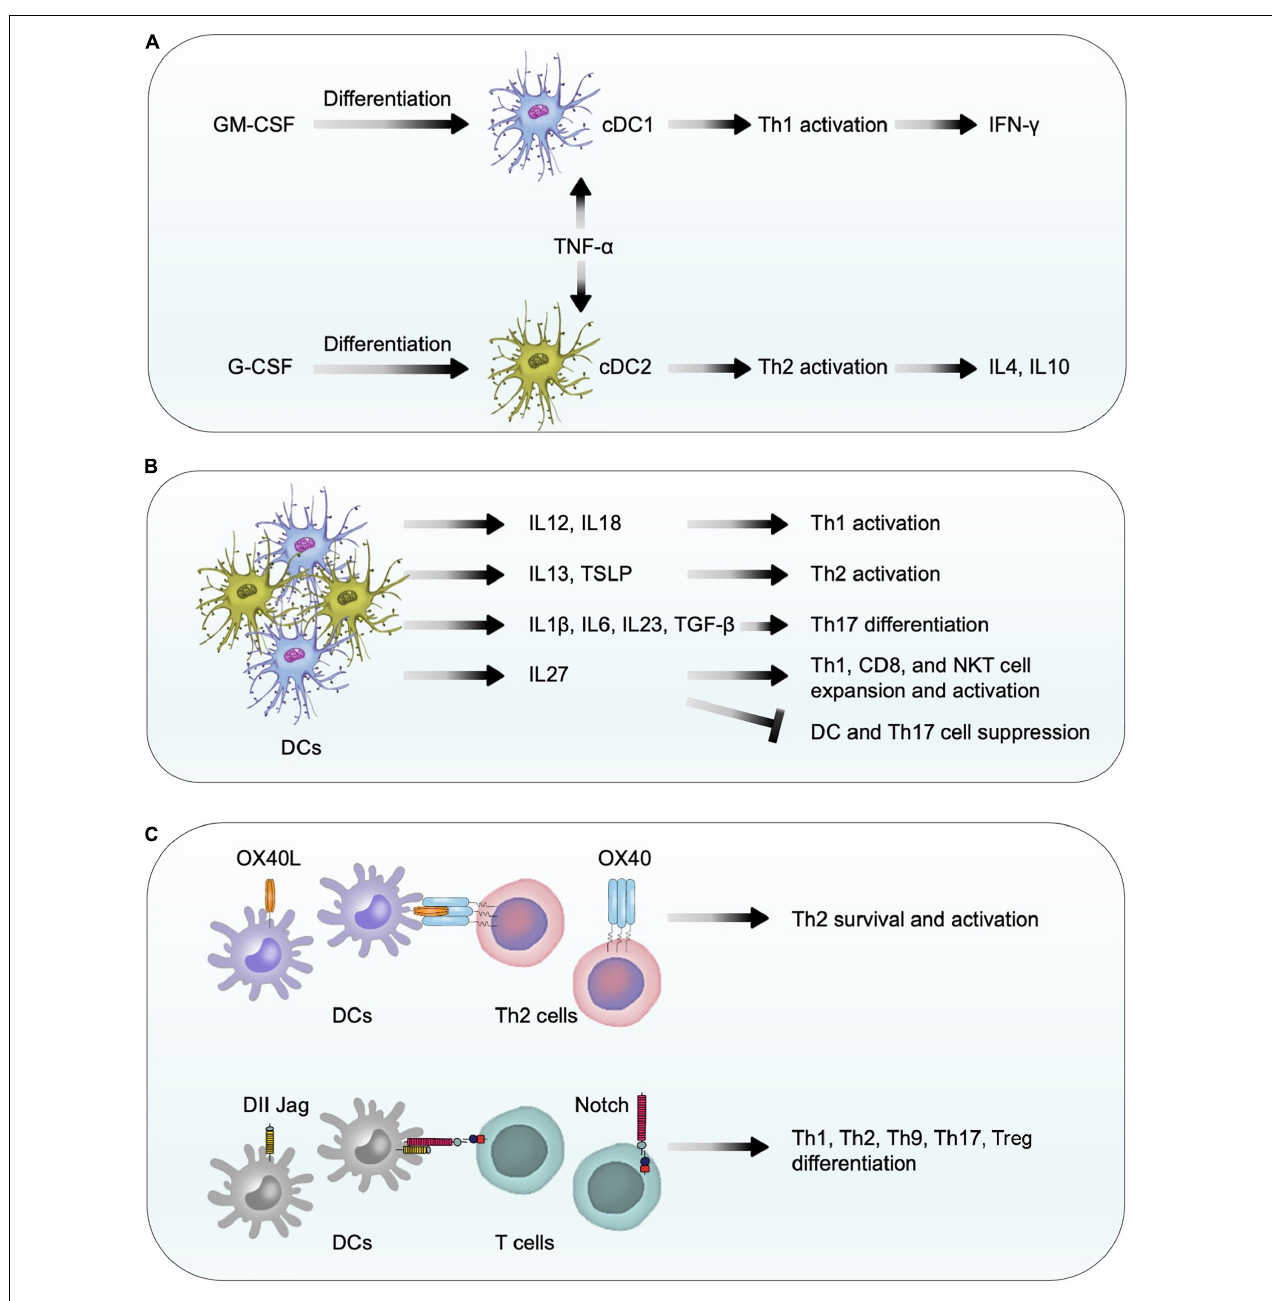
FIGURE 5 | Dendritic cell function in pressure overload-induced cardiac hypertrophy and fibrosis. (A) In response to GM-CSF and G-CSF, bone-marrow-derived CD11c + DCs differentiate into conventional DC1 and DC2 cells. TNF- α activates conventional DC1 and DC2 to release Th1 and Th2 cytokines to affect cardiac fibroblast activation, fibrosis, and cell death. (B) DCs release different types of cytokines to control T-cell differentiation, expansion, and activation. (C) Using co-stimulatory molecules OX40L, Delta-like ligands, and Jagged, DCs promote the survival, differentiation, and activation of different T-cell